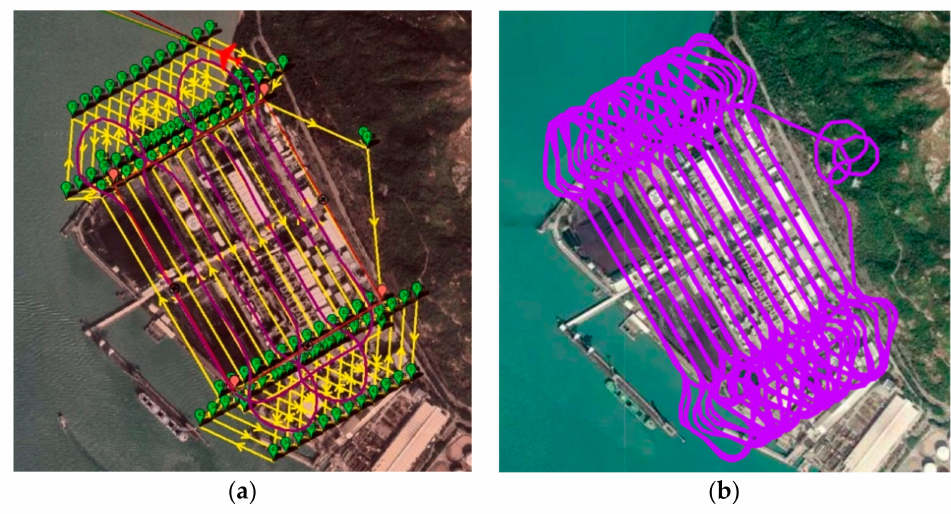
Figure 17. Bird’s eye view of the final trajectory result of cycle-Boustrophedon path in simulation platform 1 ( a ) and platform 2 ( b ).